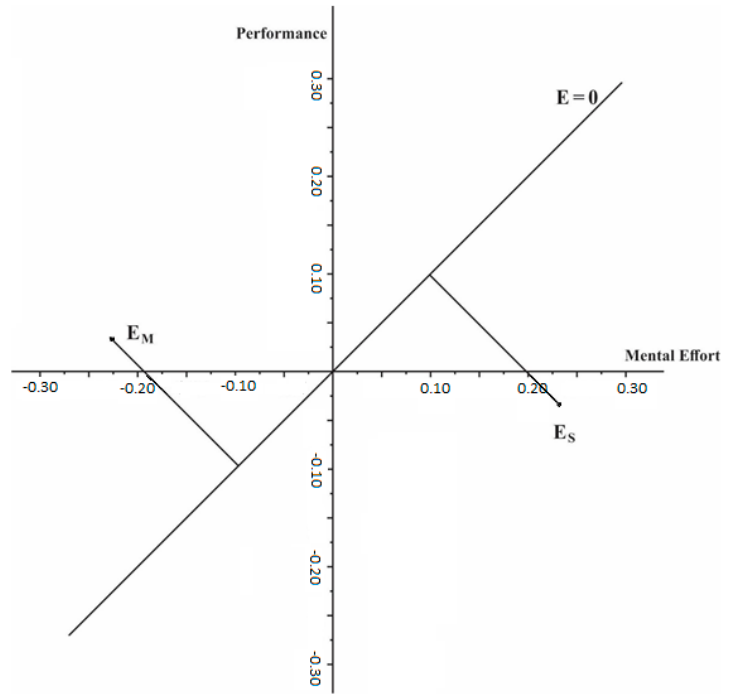
Figure 3. Instructional